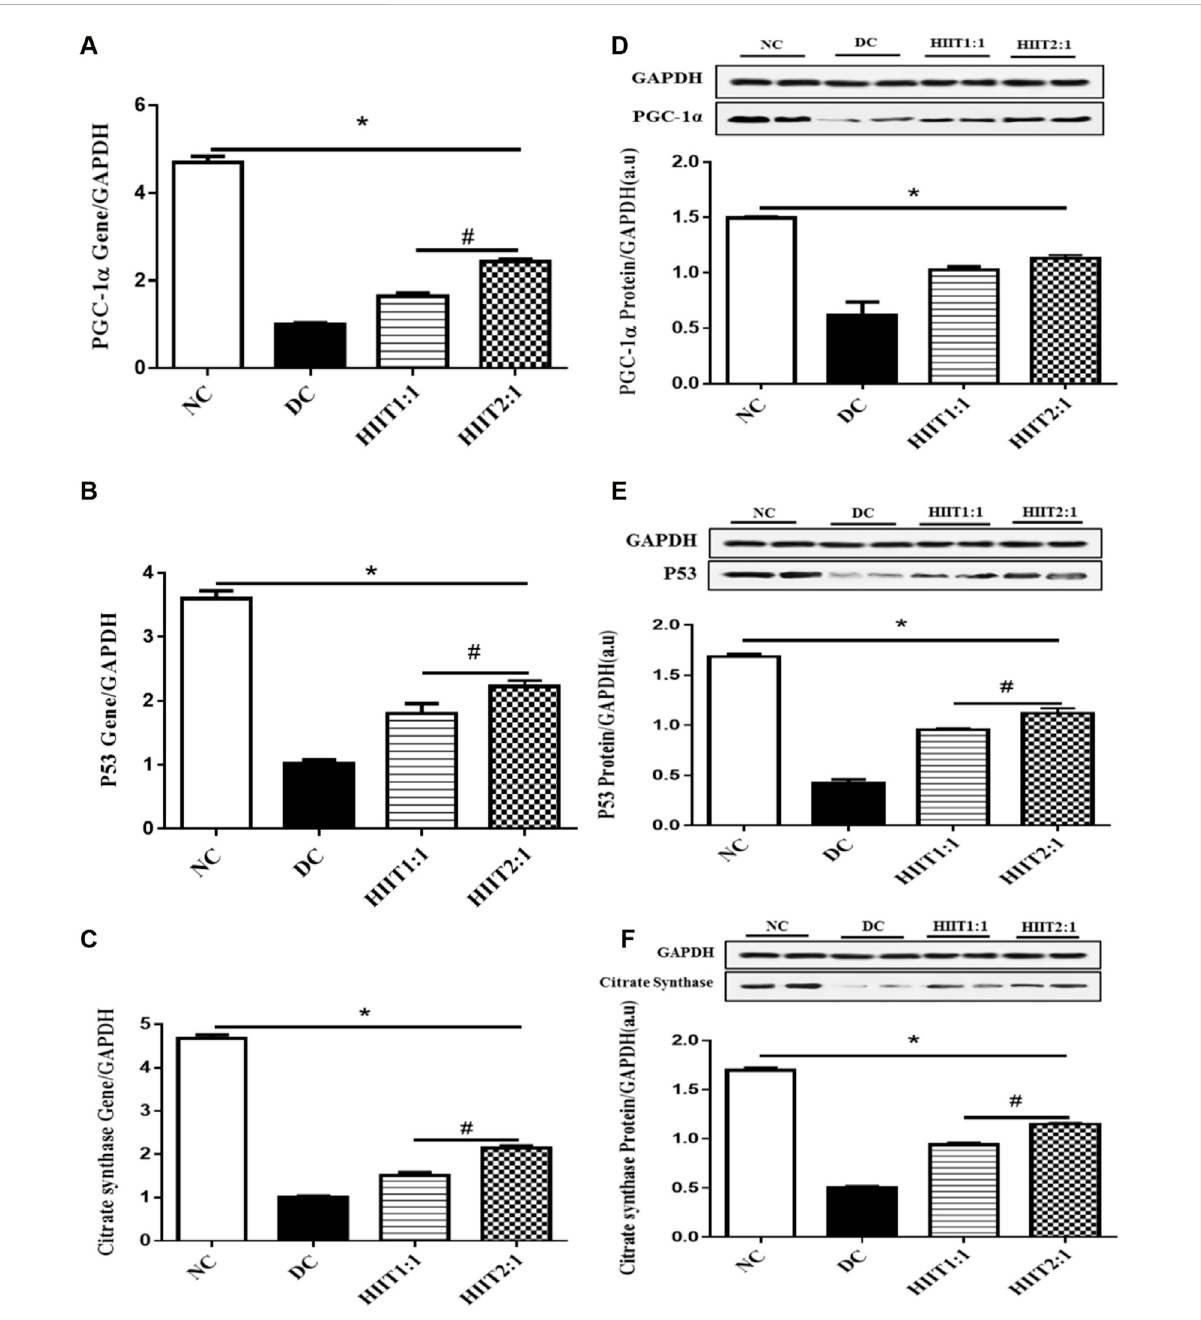
FIGURE 1 The effect of the HIIT1:1 and HIIT2:1 protocols on key regulatory factors related to mitochondrial biogenesis. (A) PGC-1 α gene expression. (B) p53 gene expression. (C) Citrate synthase gene expression. (D) PGC-1 α protein abundance. (E) p53 protein abundance. (F) Citrate synthase protein abundance. The data are presented as mean ± SEM. *: signi fi cant differences between control and other groups, #: signi fi cant differences between HIIT1:1 and HIIT2:1. HIIT: High Intensity Interval Training, n = 6 and rats trained for 4